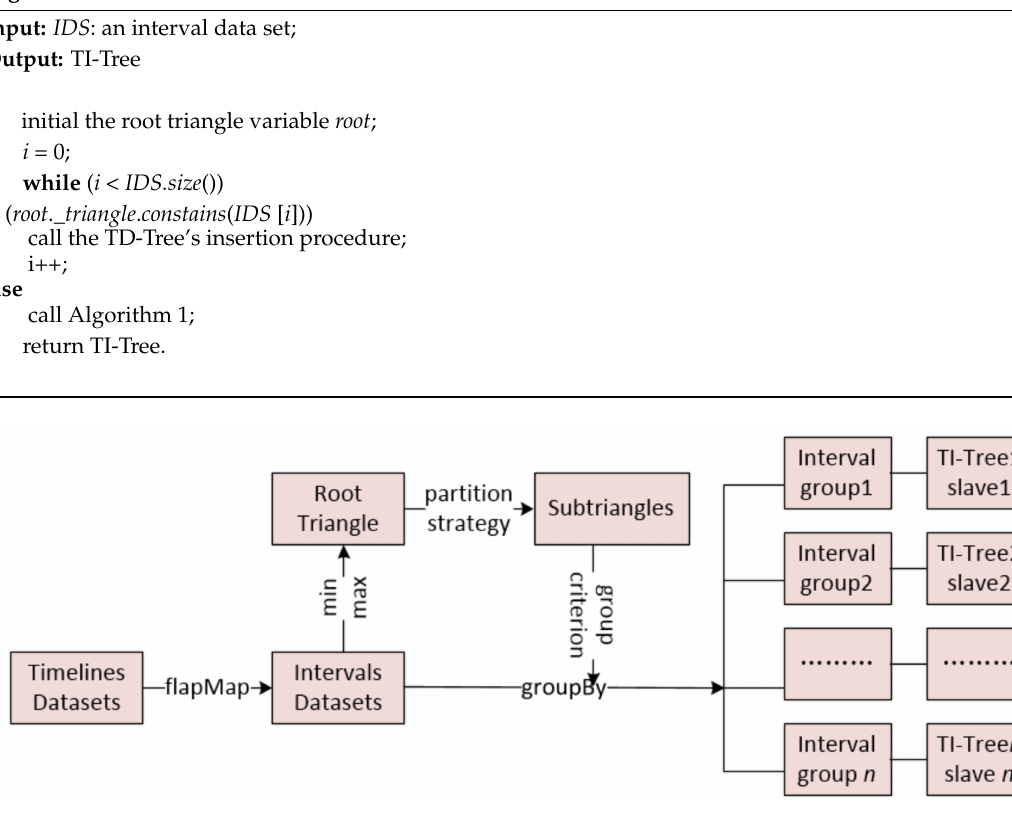
Algorithm 2: TI-Tree construction